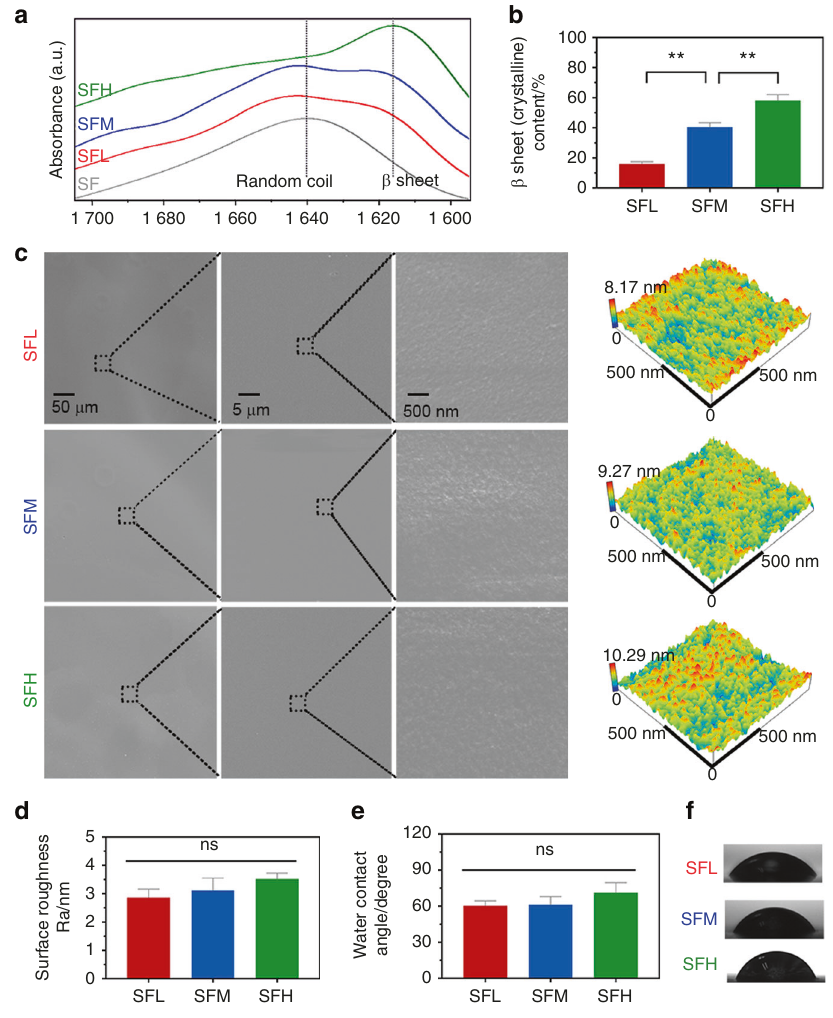
Fig. 1 Material characterization of SF substrates with different β -sheet contents. a, b FTIR absorbance spectra ( a ) of the amide I region (between 1 695 and 1 595cm − 1 ) obtained from different SF substrates and ( b ) the β -sheet contents calculated by Fourier self-deconvolution from these spectra. c Surface topography observed by SEM and AFM. d Surface roughness values analyzed by AFM. e, f Surface wettability ( e ) determined by water contact angle measurement and ( f ) representative images of water droplets. Error bars represent one standard deviation. (* P < 0.05 and ** P <